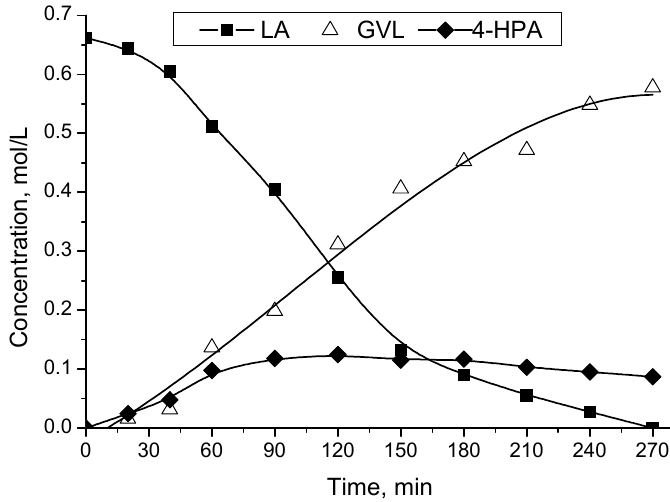
Figure 2. Typical concentrations profile for LA hydrogenation using Ru/C (1 wt. % Ru). Reaction conditions: 90 °C, 45 bar H 2 , C LA,0 = 0.6–0.7 mol/L, m cat = 0.06 g, stirring rate = 2000 rpm.